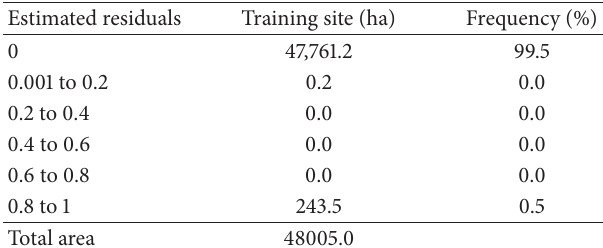
Figure 1: Predicted subalpine fir likelihood of occurrence (green). A = location of Figures 4 and 5. Table 2: Estimated residuals along with known subalpine fir population within training site for the subalpine fir occurrence